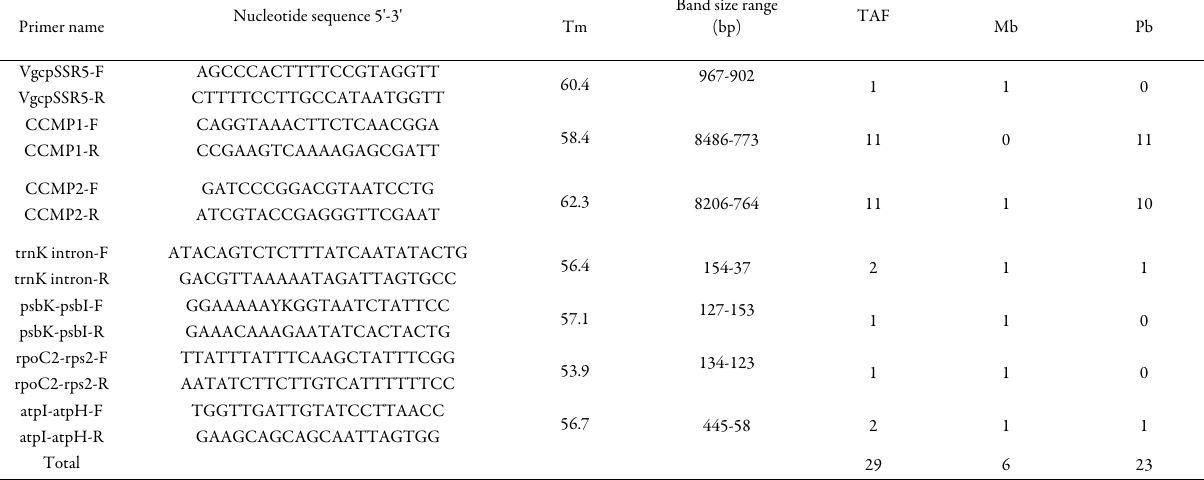
Table 3. cpSSR marker analysis of wild plant and in vitro regenerated plants (SE= Somatic embryogenesis, D= Direct regeneration and ID= Indirect regeneration).TAF= Total amplified fragments, Mb= Monomorphic bands, Pb=Polymorphic